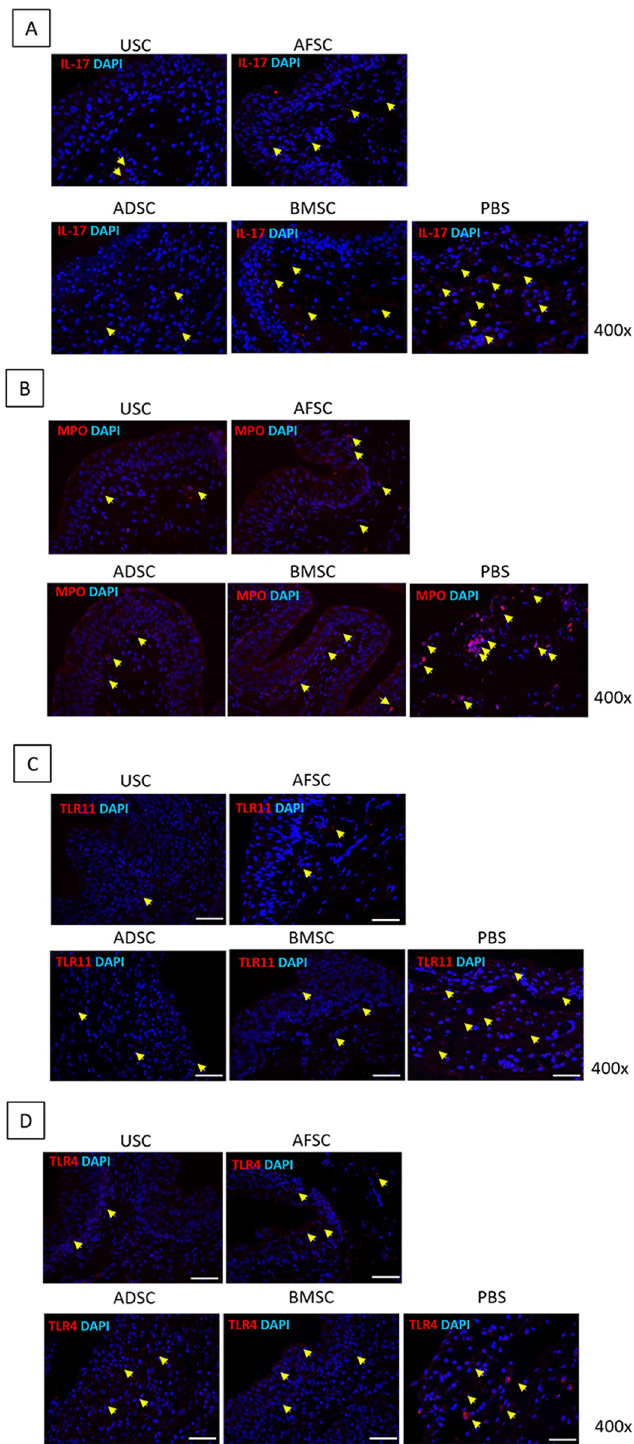
Fig 3. Immunohistochemistry results in USC-, AFSC-, ADSC-, BMSC- and PBS-injected groups. USC-injected group showed significantly inhibited expression of IL-17, MPO, TLR11 and TLR4.